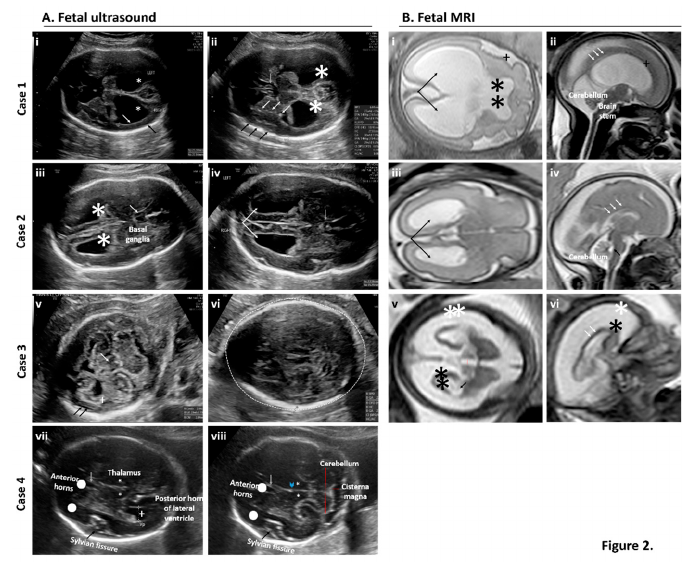
Figure 2. Prenatal examination of brain features by fetal neurosonography ( A ) and fetal MRI ( B ) for cases of suspected exposure to ZIKV. ( A ) Serial and repeat sonographic fetal imaging with neurosonography in the second and third trimester were performed. Case 1: Axial views of the fetal brain at 31 weeks and one day gestational age by best obstetrical estimate (31w1d). There is thinning of the cortex (white arrow) and reduced subarachnoid space (black arrow). Bilateral ventriculomegaly is present (star) (i). At the level of the thalami, (ii) punctiform calcifications are present within the basal ganglia (white arrows) and the subarachnoid space is reduced near the Sylvian fissure (black arrows). The cavum septum pellucidum is present but appears dysplastic (grey arrow). Bilateral ventriculomegaly is present (star). Case 2: Axial views of the fetal brain at 28w5d. Bilateral ventroculomegaly and mild colpocephaly is present (iii, star). The cavum septum pellucidum is present but dysplastic (iv, grey arrow). Bilateral colpocephaly appears asymmetric (iv, arrows). Case 3: Axial views of the fetal brain at 25w5d. There is thalamic hypoplasia (v, white arrow), severe cortical atrophy (v, cross), and a prominent subarachnoid space (v, black arrows). The posterior fossa is normal. (vi) Image is at the level of the transthalamic plane in which the biparietal diameter and head circumference is measured. Microcephaly (defined as head circumference <3SD) is present (dashed line). Case 4: Transthalamic (vii) and transcerebellar (viii) views at 29w3d. No obvious intracranial abnormalities are seen or suspected. Normal structures are labeled. Anterior horns (dots), cavum septum pellucidum (grey arrow), Sylvian fissure (black arrows), thalami (stars), and third ventricle (arrowhead). Cerebellum and cisterna magna (red lines). ( B ) Fetal MRI with axial views of the transthalamic plane and ventricular system alongside sagittal views of the cortex, cerebellum, brain stem, and corpus callosum revealed abnormalities in three of the four cases. Case 1 (i–ii): Axial and sagittal views at 31w1d. In addition to bilateral ventriculomegaly (i, arrows), there is an abnormal sulcation pattern seen in the Sylvian fissure (i and ii, cross). The leaflets of the cavum septum pellucidum were seen ventrally (not pictured) but not dorsally (i, stars). The corpus callosum was also thin near the splenium (ii, white arrows). The brain stem and cerebellum were normal. Case 2 (iii–iv): Axial and sagittal views at 28w5d. There was mild bilateral ventriculomegaly with a mild colpocephalic appearance (iii, black arrows). The corpus callosum is thin and only partially seen in the area of the splenium (iv, white arrows). The fourth ventricle is not dilated (iv, black arrows) and the brain stem and cerebellum were normal. Case 3 (v–vi): Axial and sagittal views at 25w5d. Severe cortical atrophy is present (v–vi, black stars) with massive enlargement of the subarachnoid space (v–vi, white stars). The lateral ventricles (v, black arrows) are mildly dilated, as is the third ventricle (v, red line). In the midsagittal plane, the corpus callosum is difficult to visualize (vi, white arrows). In real time, the brain matter “jiggled” with fetal movement due to severe atrophy and thinning (supplemental video). An MRI for Case 4 was not performed given the absence of sonographic findings by